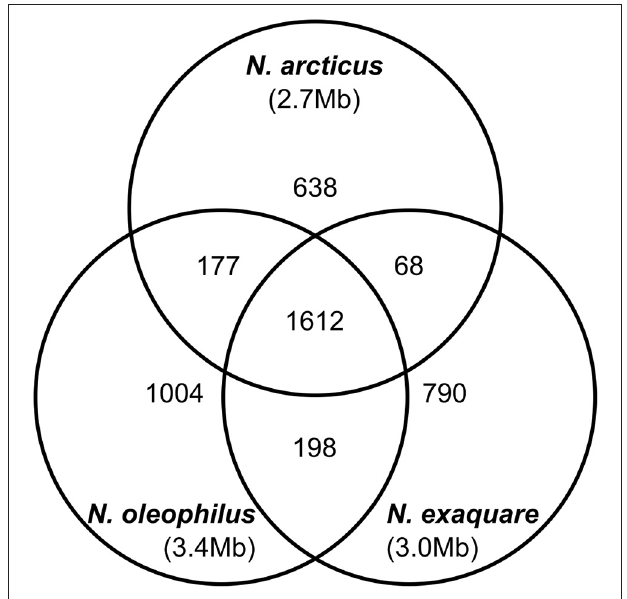
FIGURE 5 | Genomic comparison of strains from candidate genus Nitrosocosmicus. The Venn diagram shows the distribution of homologous protein families among the three Ca . Nitrosocosmicus genomes available, as well as their genome sizes (see text for details).